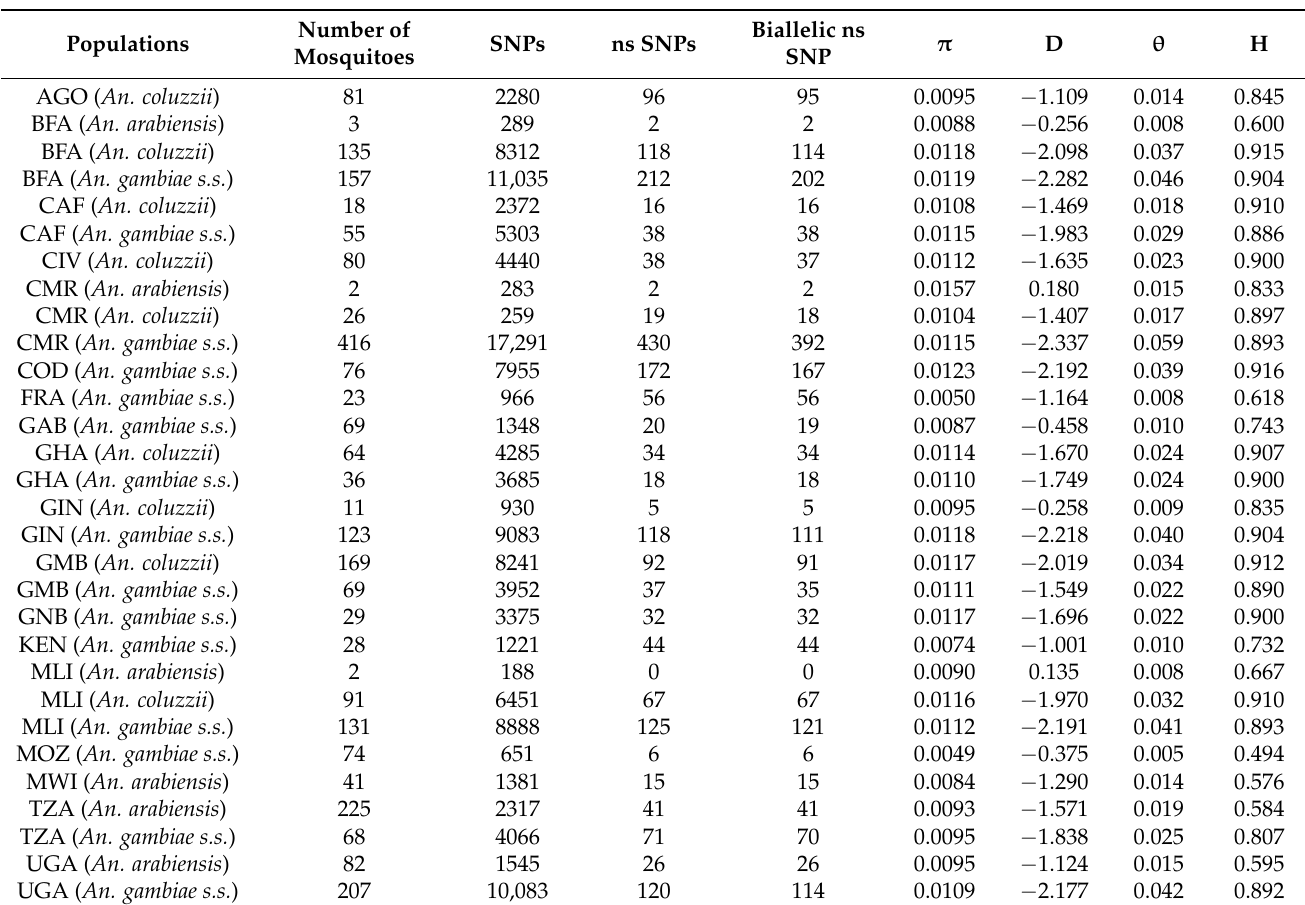
Table 1. Summary of the diversity statistics based on SNPs of the Fruitless gene of Anopheles gambiae complex. Segregating sites were calculated within the whole gene. Median of π , D, θ , and H calculated in a window of 0.5